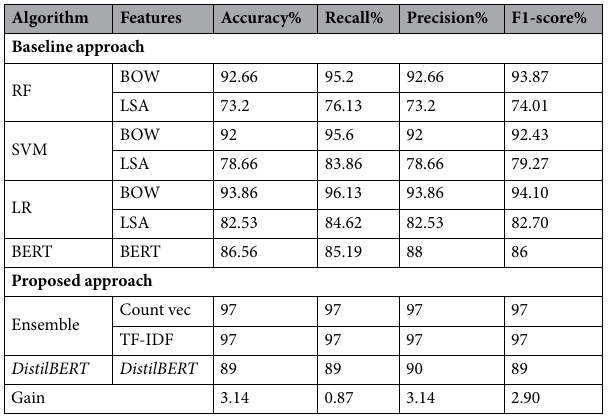
Table 8. Performance comparison of proposed approach and baseline approach with 10 authors.